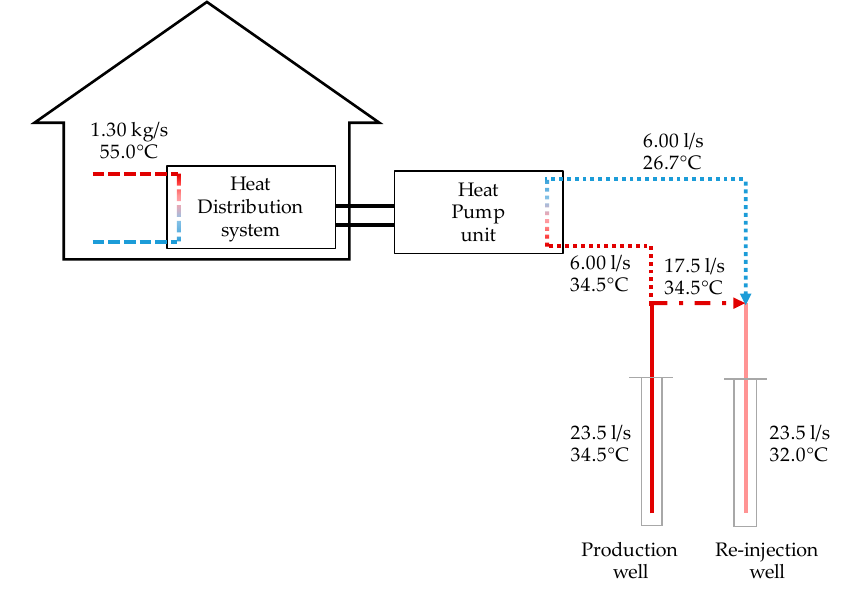
Figure 1. Scheme of the system operation.